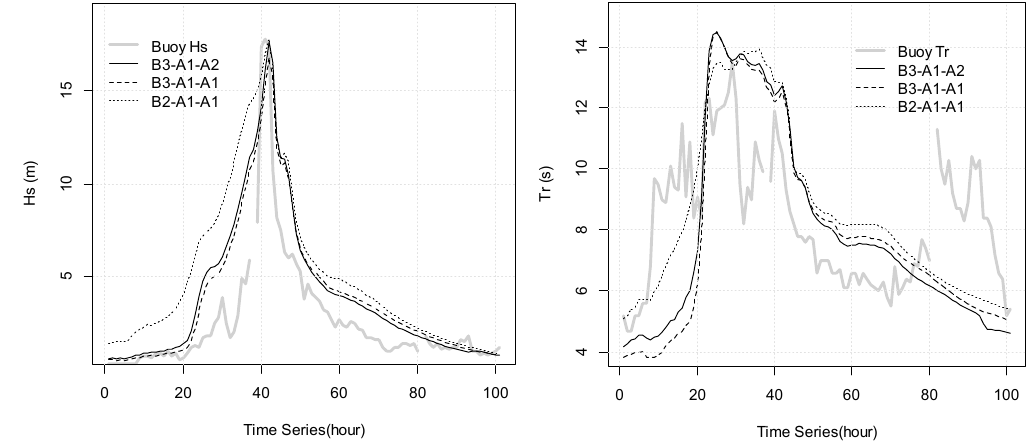
Figure A7. Comparison of typhoon waves induced by Typhoon Meranti (14-2016) at buoy Eluanbi: the standard H10 is indexed as B2-A1-A1, the model with varying parameter b without an asymmetric typhoon structure is indexed as B3-A1-A1, and MH10 is indexed as B3-A1-A2.